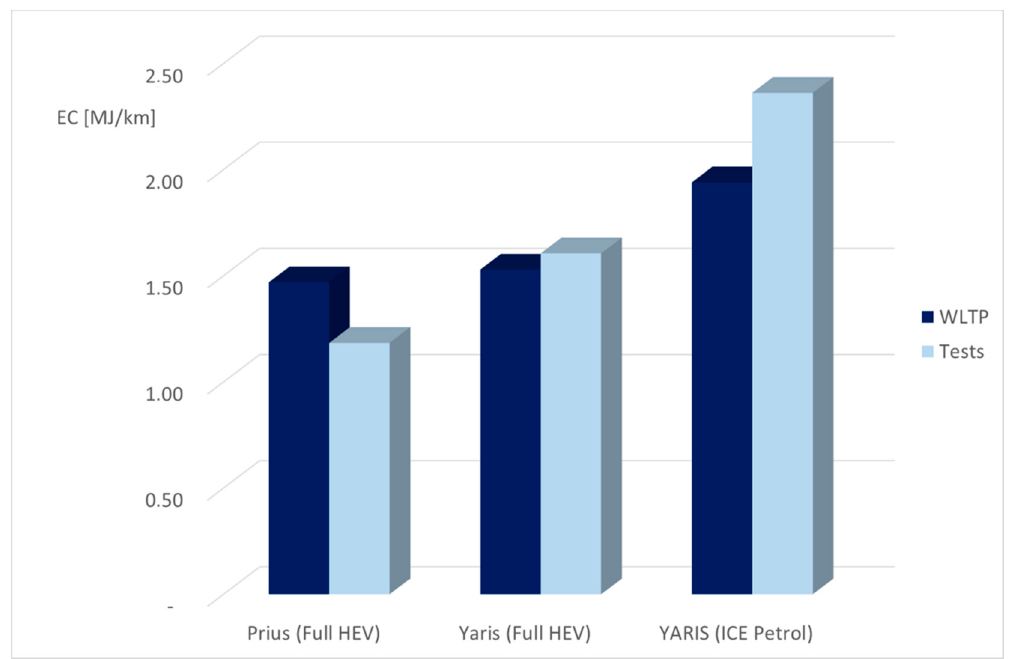
Figure 20. Comparison between test and WLTP procedure energy consumption.